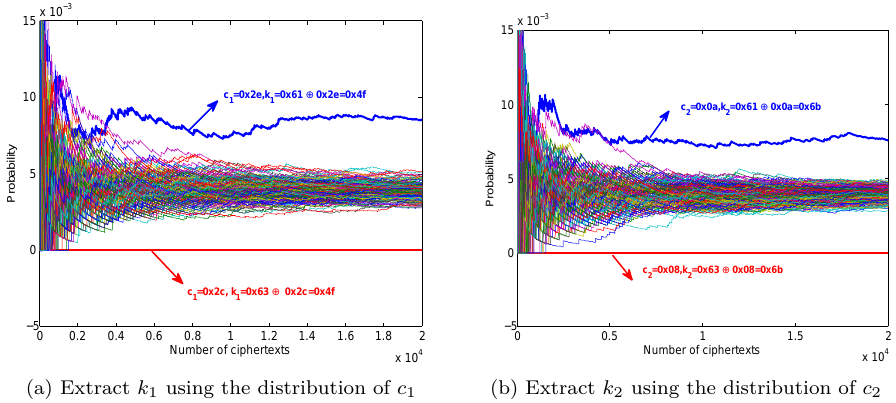
Figure 4: Exemplary PFA on AES-128 using distributions of ciphertext